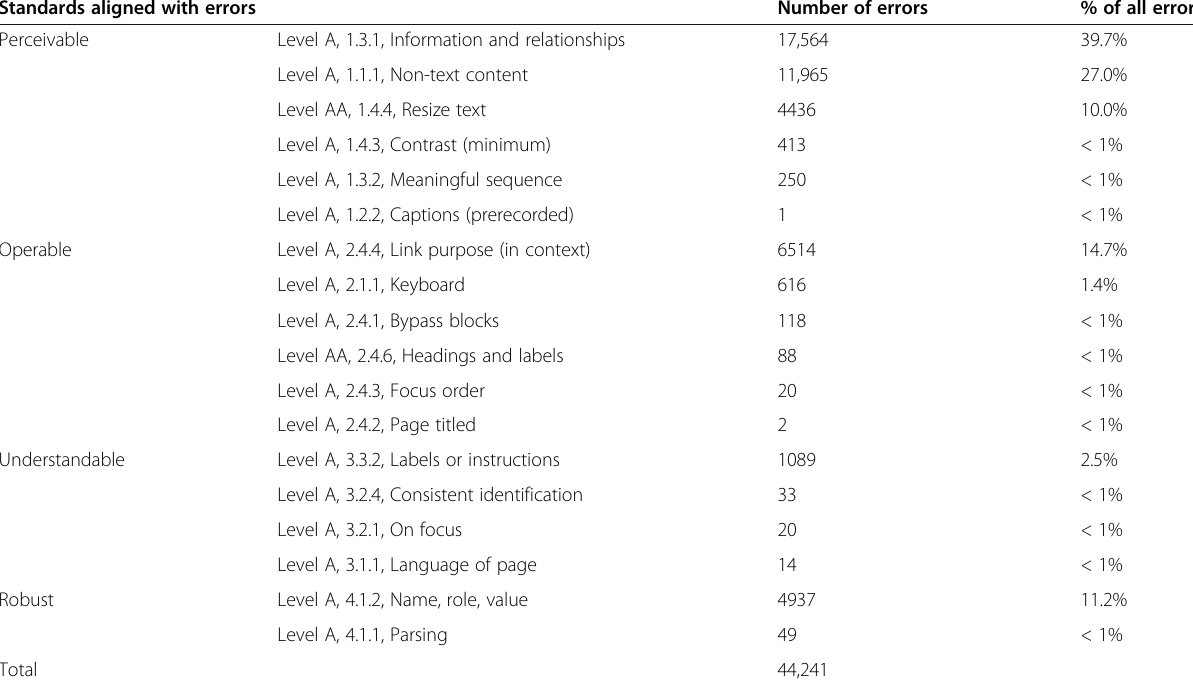
Table 4 Descriptive statistics of web accessibility errors ( N = 44,241) on physics curriculum webpages published on institutional webpages ( N = 73), by error type Standards aligned with